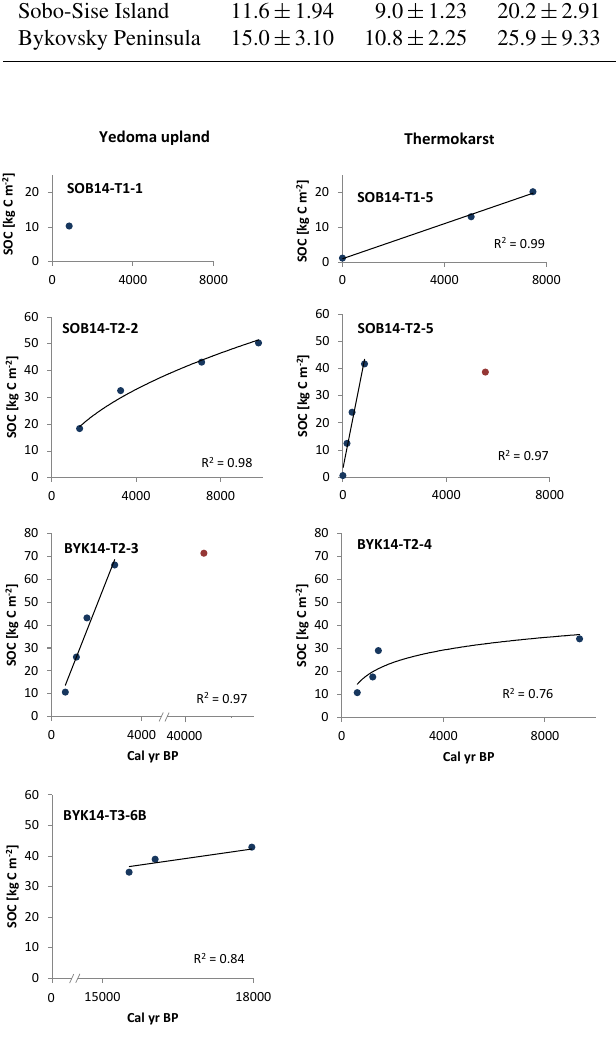
Figure 6. Relationship between cumulative SOC storage and age. Cal yrBP for radiocarbon dated samples (blue dots) for each core. Lines indicate the best fit correlation of the points excluding outliers (red